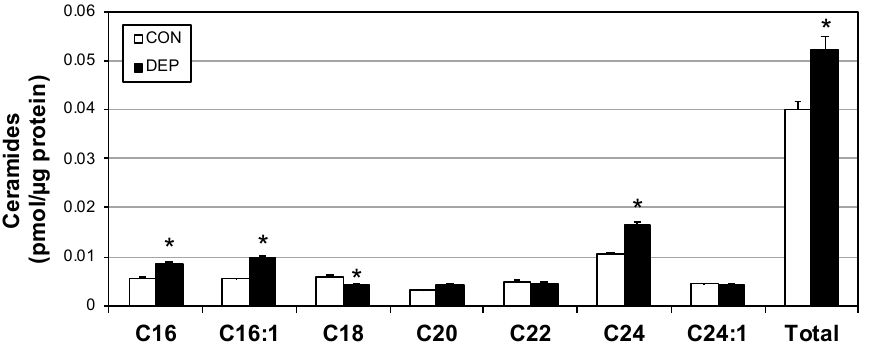
Figure 3. Diesel exhaust particle exposure selectively increases alveolar macrophage ceramides. Following 4 weeks of room air (CON) or diesel exposure (DEP), ceramides were quantified from mouse alveolar macrophages. n = 8. * p < 0.05; CON vs. DEP.